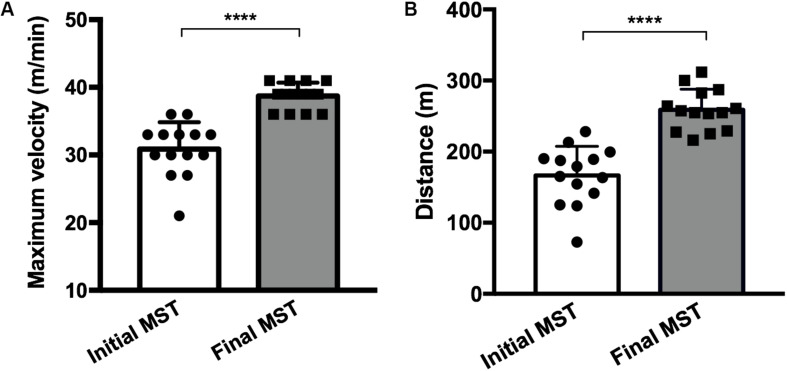
Maximum velocity (A) and the total running distance (B) achieved before (initial MST) and after (final MST) the exercise protocol showing a performance improvement after training. Fourteen mice in each group (trained, N = 7; trained + LPS, N = 7; all animals from the trained + LPS group received the LPS injection 24 h after the final MST). Data were compared with t-test and Shapiro–Wilk test; ****p < 0.0001. Data are presented as mean ± SD.